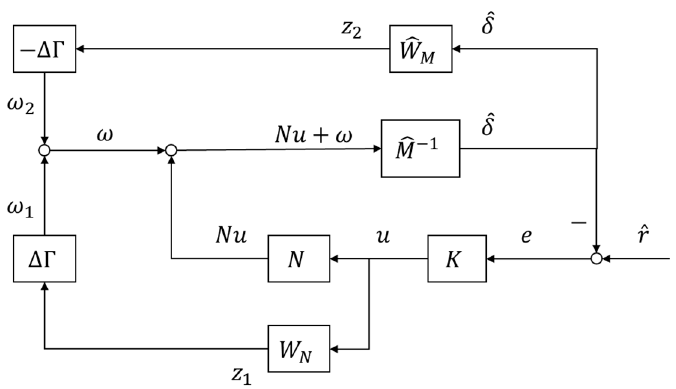
Figure 8. The equivalent diagram of Figure 7 .